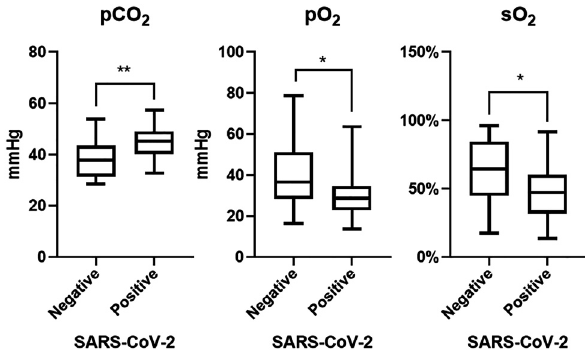
Figure 1: Graphs depicting mean and range of venous blood gas data of patients tested negative and those tested positive for